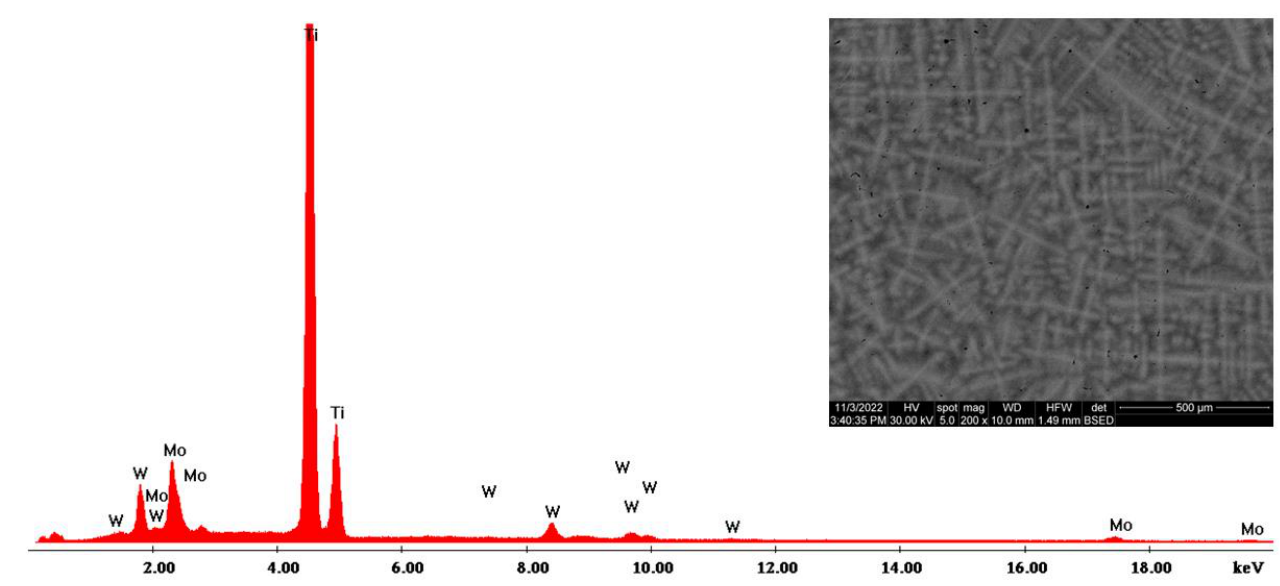
Figure 8. SEM—EDS characterization of Ti19Mo9W alloy (Code 3).